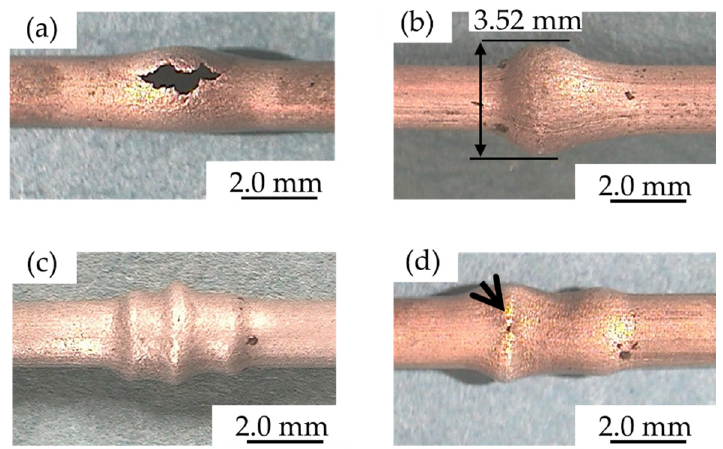
Figure 13. Deformation characteristics of the small ZM21 tube deformed under the various internal pressure conditions: ( a ) a fracture ( α = 90%); ( b ) bulge without fractures or wrinkles ( α = 80%); ( c ) a wrinkle ( α = 70%); ( d ) a wrinkle and folding ( α = 50%).